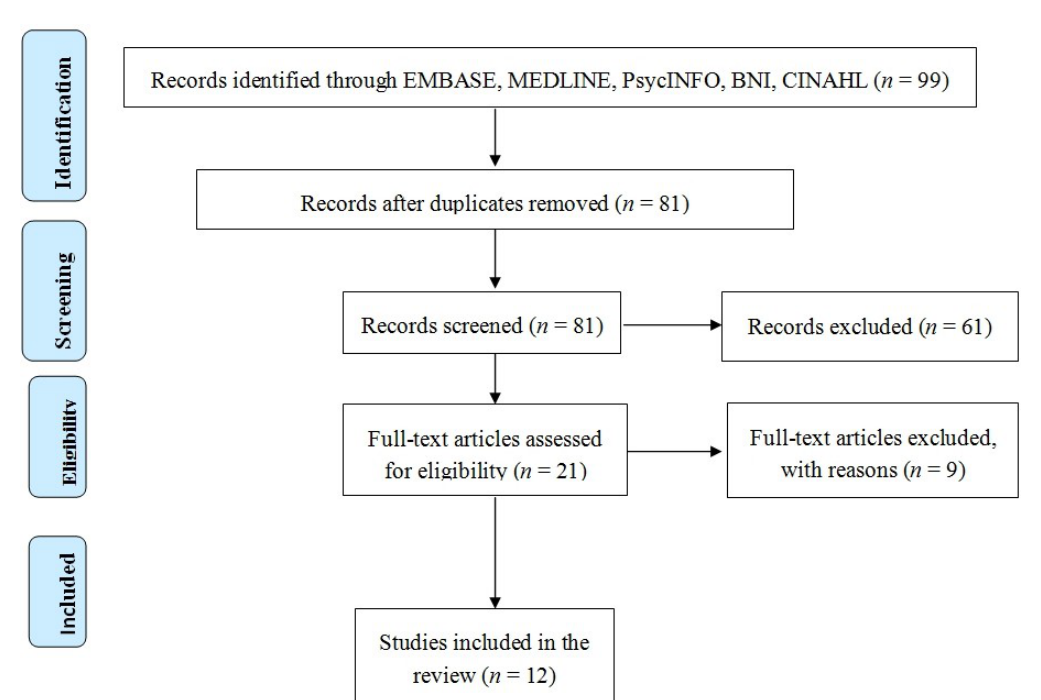
Figure 1. PRISMA of abstracts returned.